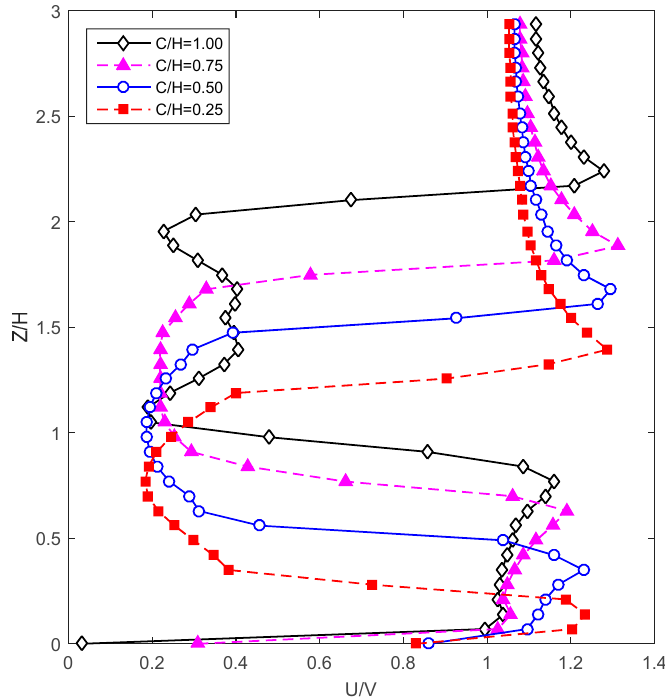
Figure 13. A comparison of flow velocity at line ( x = − 2 D , y = 0) against vertical height from C / H = 0.25– 1.0.